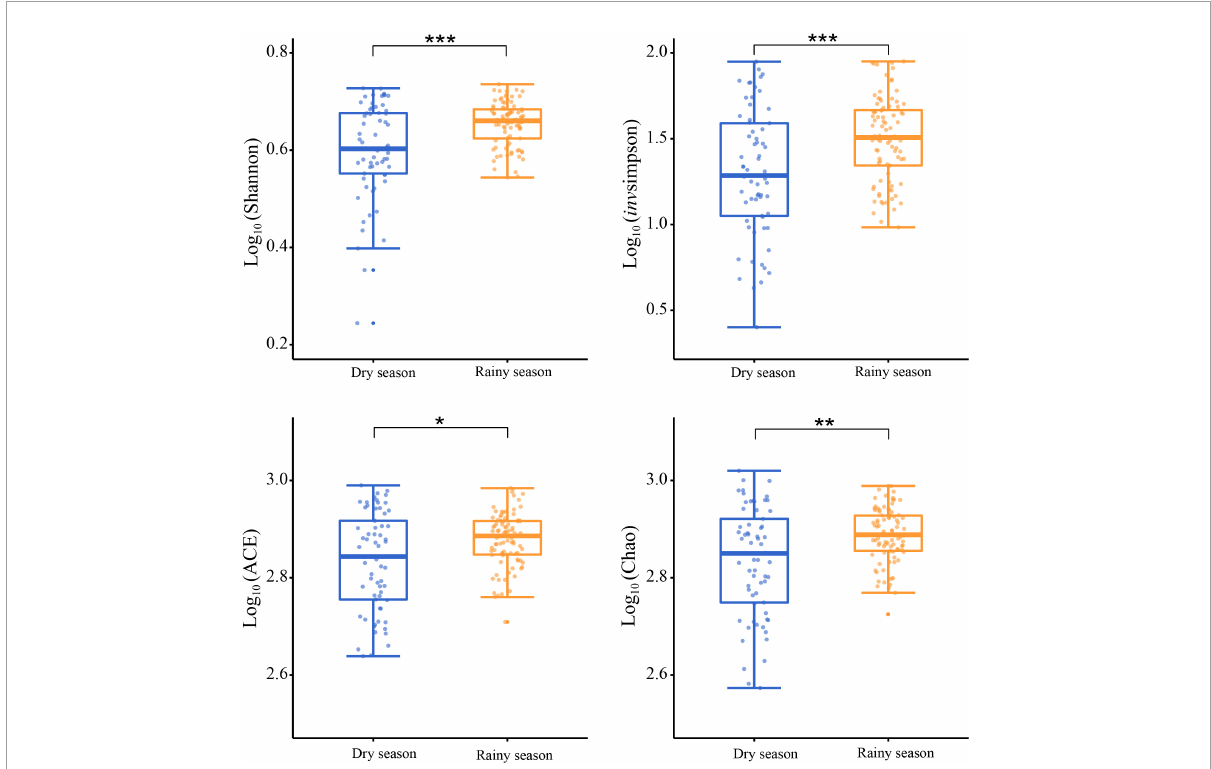
FIGURE3 Comparison of the alpha diversity in gut microbiota between the dry and rainy seasons. Asterisks indicated a significant difference, with “*” for p < 0.05, “**” for p < 0.01, and “***” for p < 0.001.